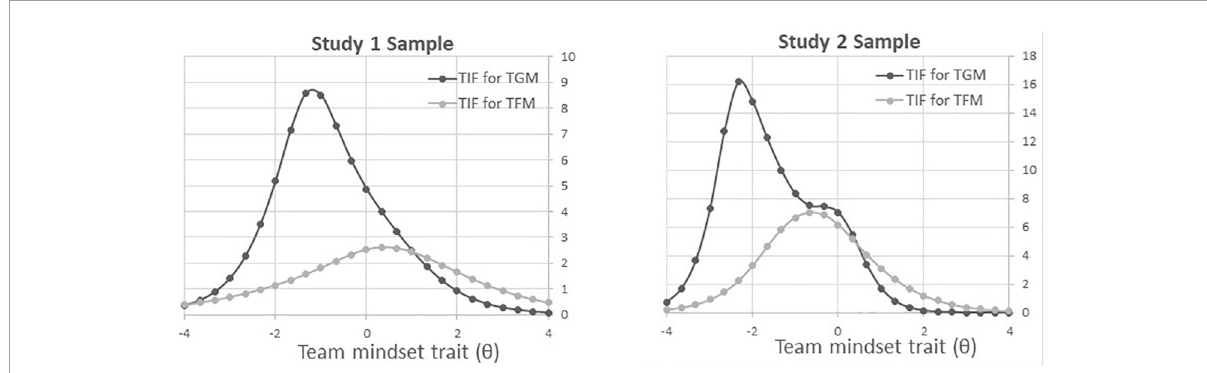
FIGURE2 Item response theory (IRT) test information curve for team growth and fixed